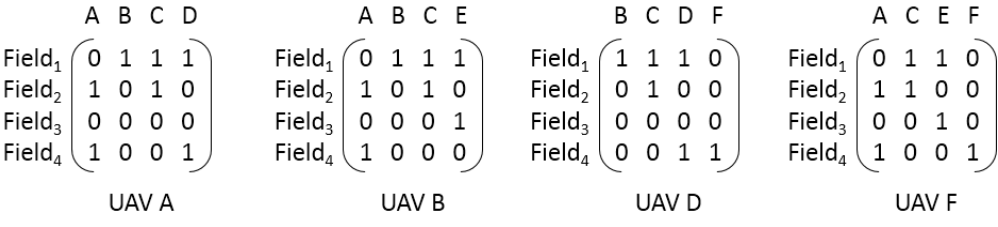
Figure 12. The result of mission decomposition and one possible mission planning strategy.